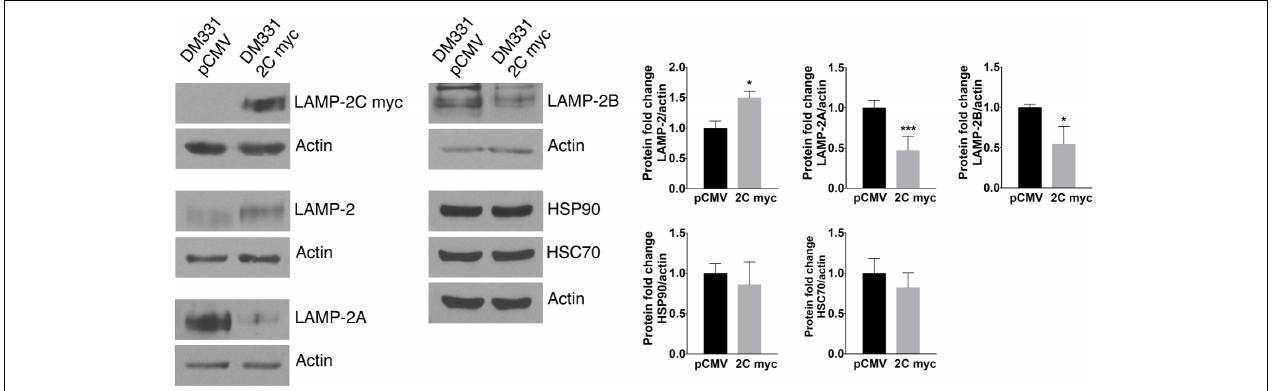
FIGURE 3 | LAMP-2C ectopic expression in melanoma cells altered LAMP-2A and LAMP-2B protein expression. LAMP-2C myc, total LAMP-2, LAMP-2A, LAMP-2B, HSC70, HSP90, and actin were detected in DM331 pCMV and DM331 2C myc cells. The normalized expression of each protein was set equal to one for DM331 pCMV cells for relative comparison with protein levels in DM331 2C myc cells. Data were analyzed by two-tailed, unpaired Student’s t -test. ∗ p < 0.05 and ∗∗∗ p < 0.001 ( n =